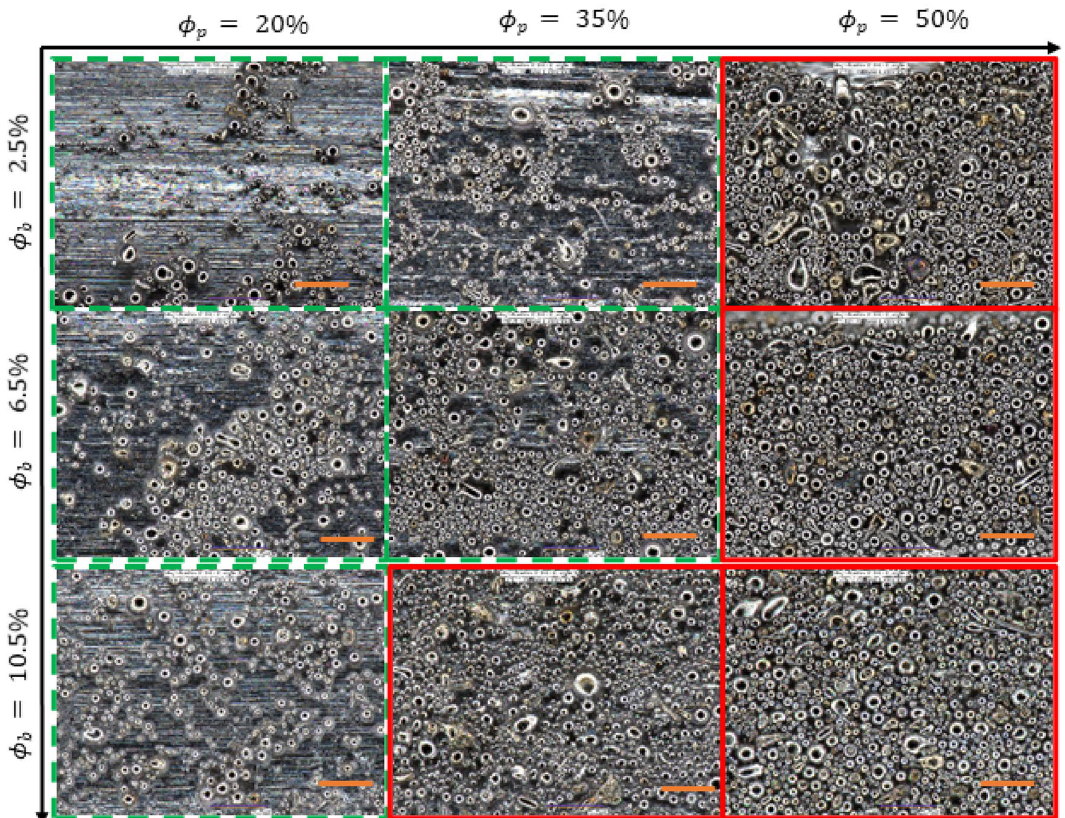
Figure 7. Surface morphology of the coated substrate at different volume fractions of binder ( φ b =2.5%,6.5% and 10.5%) and particles ( φ p =20%,35% and 50%). The pictures were taken 1000X zoom. The dashed green line bounded figures correspond to the heterogeneous regime and the red solid line bounded figures show the effective viscosity regine. 50 µm scale